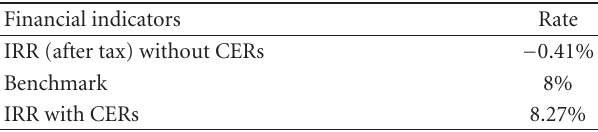
Table 4: The financial indicators of the